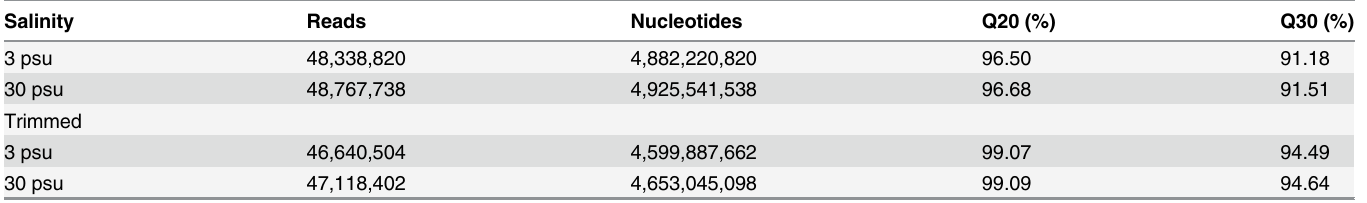
Table 1. Summary of Illumina-expressed short read production and filtered transcriptomic responses to salinity stress in Litopenaeus vannamei . Salinity